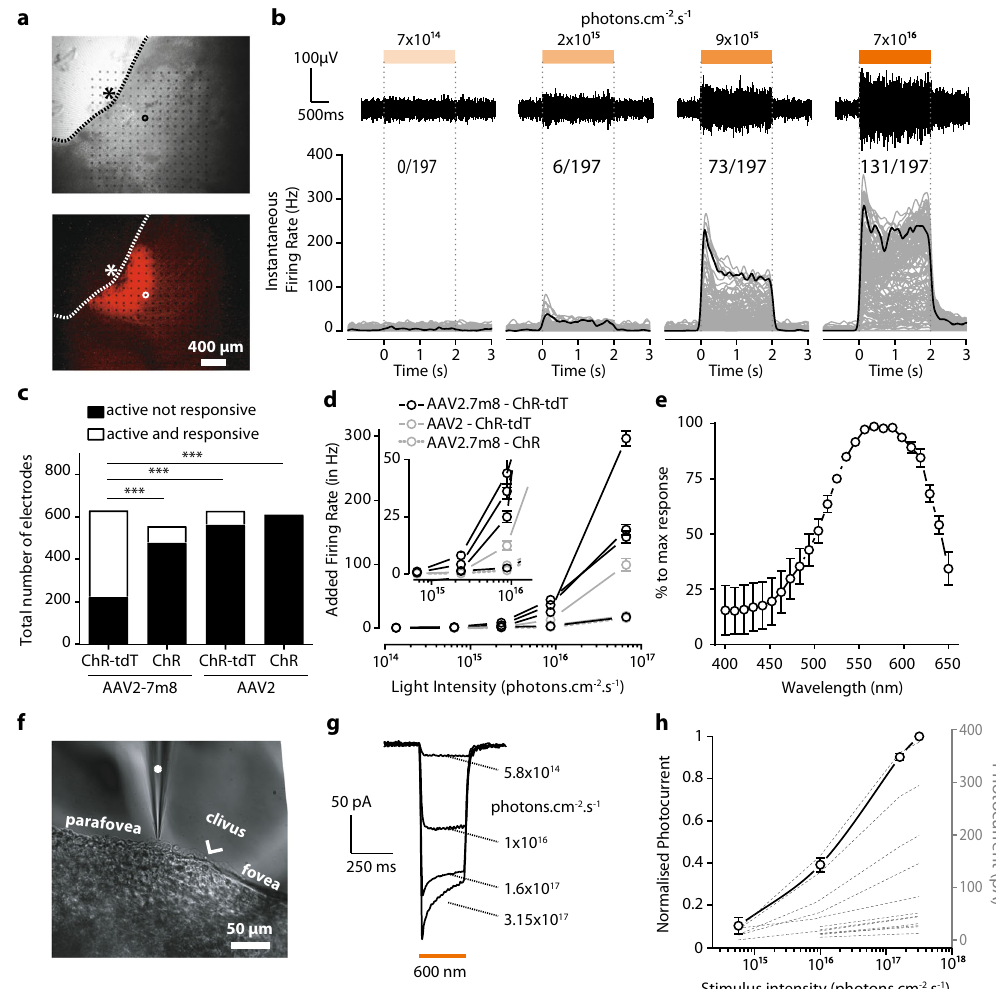
Fig. 1 Higher transfection ef fi ciency with AAV2.7m8 – ChR-tdT in NHP retinas. a Images of a primate retina expressing AAV2.7m8 – ChR-tdT as observed during MEA recordings. Top: Infrared image, electrodes can be seen as black dots; the retina explant in gray, and its limit is shown as a dashed line. An asterisk indicates the center of the fovea, the circle indicates the example electrode in b . Bottom: Epi fl uorescence image of the same piece of the retina. The strong perifoveal expression can be observed in the mounted hemifovea thanks to tdT fl uorescence. b , top: Raw signal recorded from one sample electrode (circled electrode in a ) in response to stimuli of increasing intensities (7 × 10 14 , 2 × 10 15 , 9 × 10 14 , and 7 × 10 16 photons cm − 2 s − 1 ). Light to dark orange rectangles indicate the temporal duration (2 s) of the different intensities of light stimulation delimited by dashed vertical lines. Voltage and temporal scale on the left (bottom) Spike density function for all the active electrodes of the hemifovea shown in a (gray lines, n = 197 lines) as a function of time, before, during, and after a two-second stimulus. Firing rates were averaged over ten repetitions. Black lines show the mean fi ring rate for the electrode displayed in the upper panels and circled in a . The numbers at the top indicate the number of responsive electrodes per light intensity compared to total active electrodes (i.e., electrodes where spikes are recorded). c Total of active electrodes recorded for the four different constructs (four experiments per construct, theoretical maximum: 1024 electrodes per construct). Data are then split for each construct between active and responsive electrodes (white) and active but unresponsive electrodes (black). The proportion of active and responsive electrodes is maximal for AAV2.7m8 – ChR-tdT ( n = 4, Fisher contingency test, P < 0.0001). d Mean additional fi ring rate per responsive retina for the four constructs ± SEM (four responsive retinae for AAV2.7m8 – ChR-tdT, two for AAV2 – ChR-tdT, one for AAV2.7m8 – ChR, zero for AAV2 – ChR). Stimulation at 590 nm ±15 nm. The inset shows a zoomed image around the fi rst responsive intensity: 2.34 × 10 15 photons cm − 2 s − 1 . e Mean normalized action spectrum for three retinas expressing AAV2.7m8 – ChR-tdT ± SEM. f Infrared image of the perifoveal region from a retina treated with AAV2.7m8 – ChR-tdT and recorded by two-photon targeted patch clamp. The patch-clamp electrode is indicated with a white asterisk, the clivus ocularis is indicated, separating the fovea from the parafovea. g , h Whole-cell patch-clamp recordings of ChR-tdT-expressing macaque perifovea neurons. g Photocurrent traces from one recorded cell at different light intensities. h ChR-induced photocurrents peaks are represented as a function of light intensity for each individual recorded cell (dashed lines, n = 17), the solid line represents the population-averaged photocurrent after normalization to maximal peak value + / − SEM. Light stimulation intensity ranged from 5.8 × 10 14 to 3.2 × 10 17 photons cm − 2 s − 1 . With the AAV2.7m8 – ChR-tdT combination, we recorded 18 responsive cells (5, 0, 7, 6 cells/retina), whereas only four responsive cells (0, 3, 1, 0 cells/retina) were obtained with the AAV2 – ChR-tdT construct. In the absence of tdT fl uorescence, for AAV2.7m8 – ChR and AAV2 – ChR, extracellular recordings were performed on COMMUNICATIONS BIOLOGY| (2021) 4:125